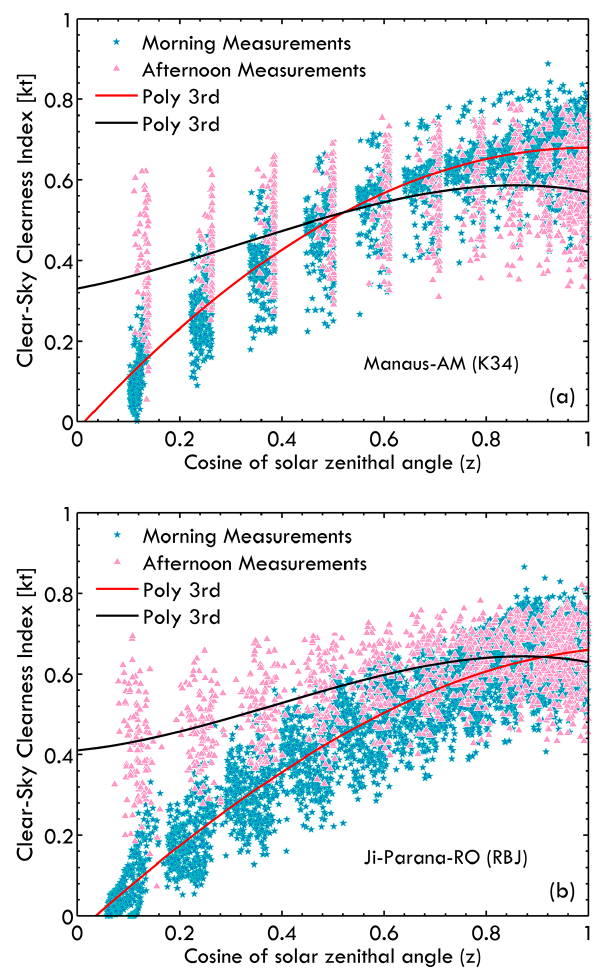
Figure 2. Scatter plots and regressions between clear-sky clearness index and the cosine of solar zenithal angle for the K34 site near Manaus (2000–2009) (a) and for the RBJ site in Ji-Parana (2000– 2002) (b) .